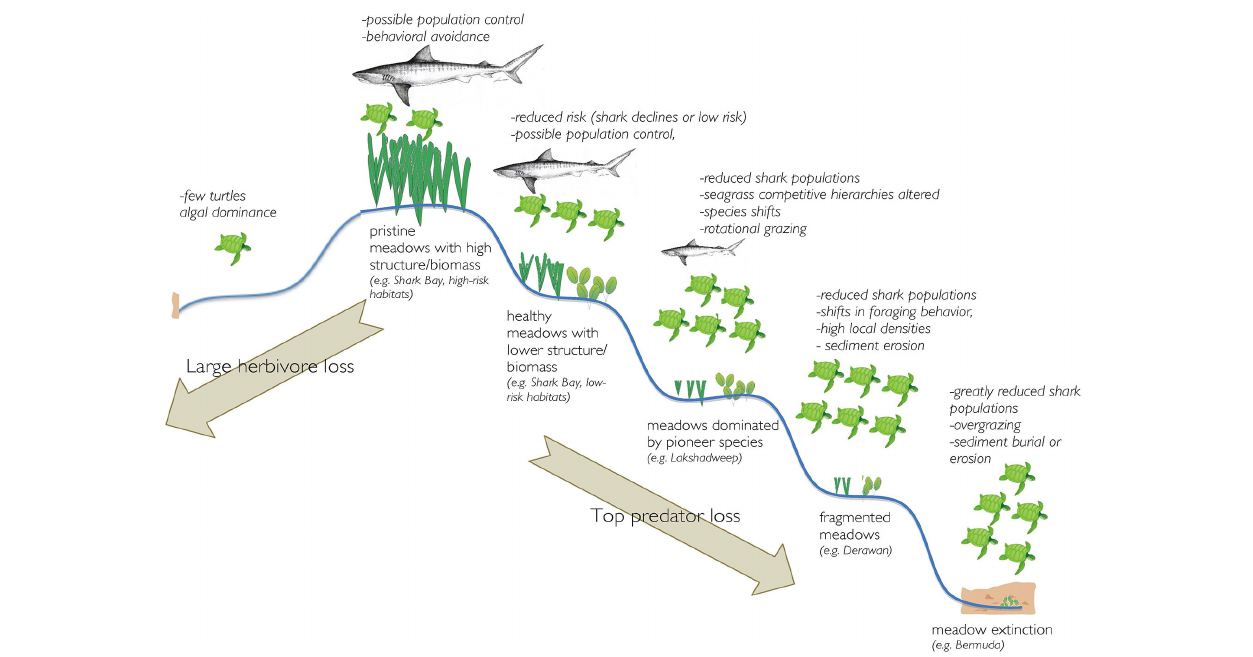
FIGURE 2 | Schematic representation of potential ecosystem responses to loss of turtles (moving from the top to the left) or loss of large sharks with turtle conservation (moving from the top to the right).